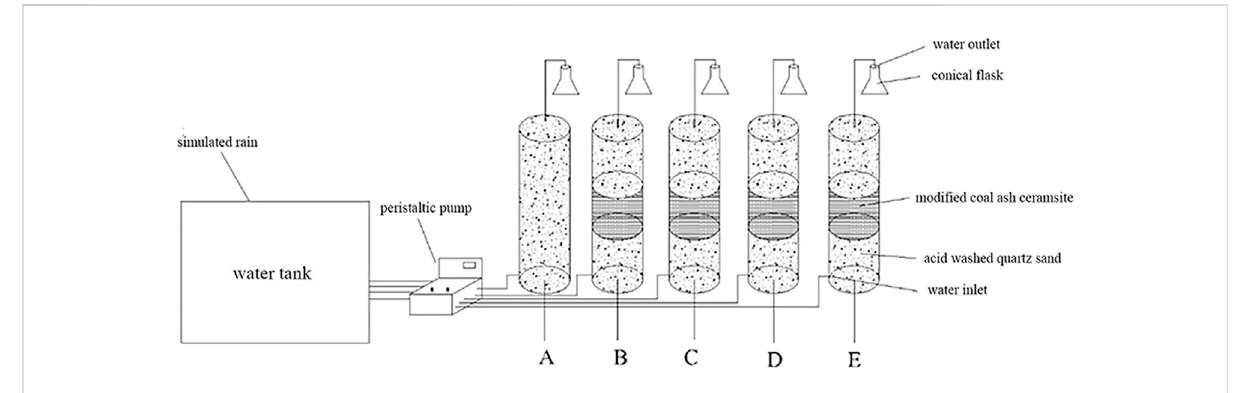
FIGURE 1 Diagram of the cylindrical experimental